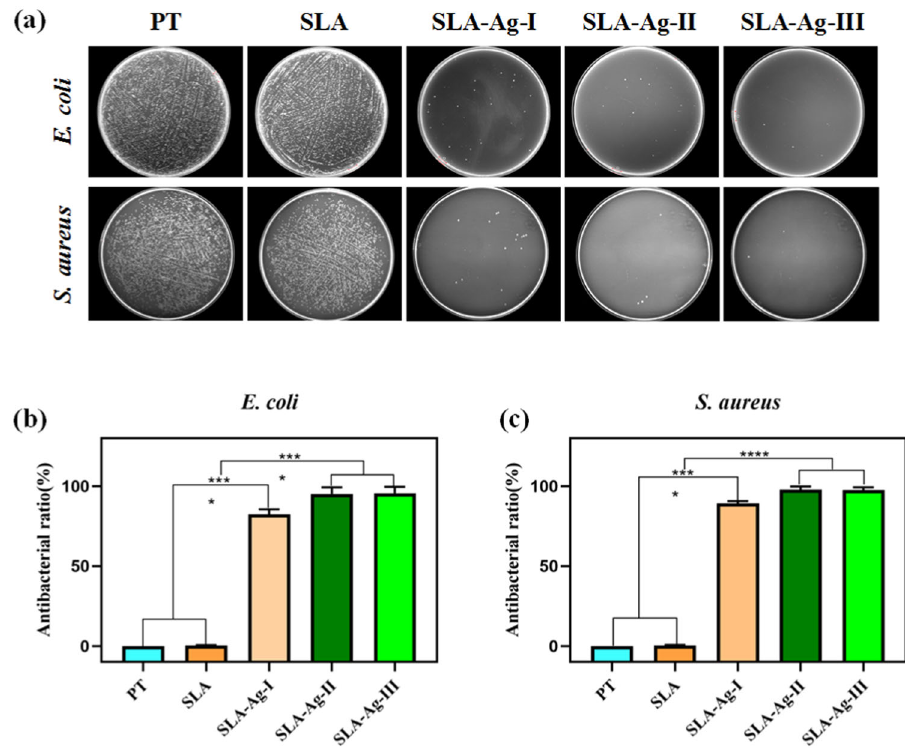
Fig. 3 a Photographs of re- cultivated E. coli and S. aureus collected from the samples. Antibacterial ratio against E. coli ( b ) and S. aureus ( c